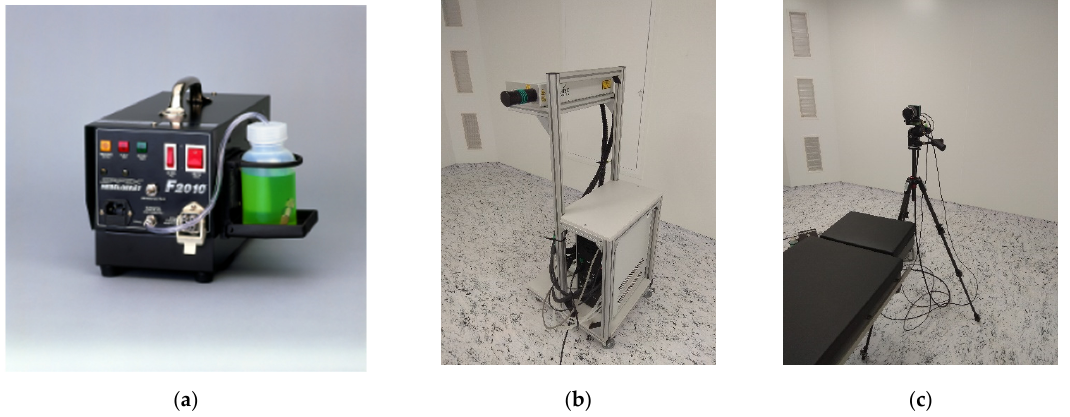
Figure 13. Devices for scanning speed profiles using the PIV method: ( a ) Safex F2010 smoke generator; ( b ) Dantec Dual PIV laser; ( c ) High FPS camera.